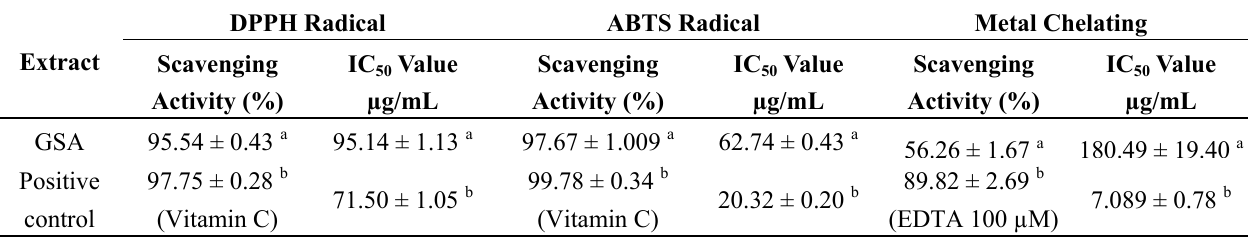
Table 1. DPPH, ABTS radical scavenging and metal chelating activities of